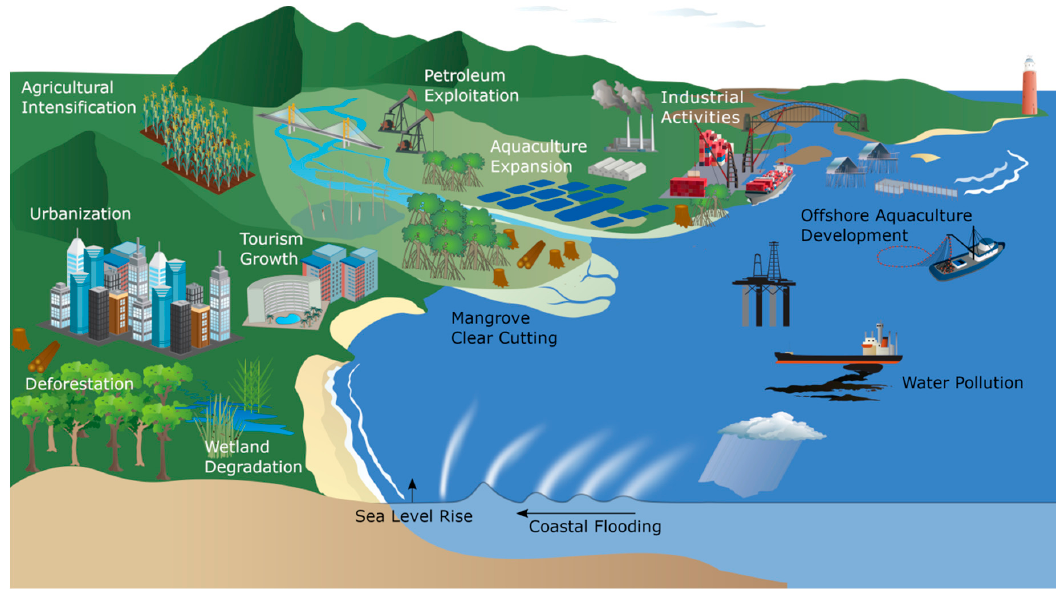
Figure 1. Activities and impacts in the coastal zone (individual symbols’ source: courtesy of the Integration and Application Network, University of Maryland Center for Environmental Science).